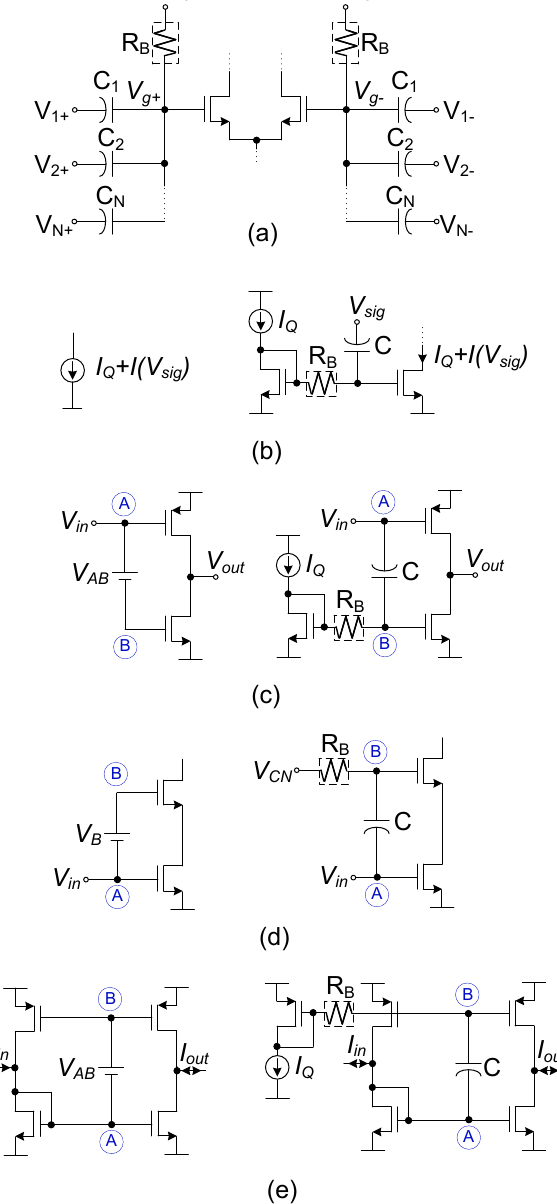
Figure 4. Quasi-floating gate (QFG) techniques for amplifier design. ( a ) QFG input pair. ( b ) Adaptive bias current source. ( c ) QFG class AB stage. ( d ) Dynamic cascode biasing. ( e ) Class AB current mirror.